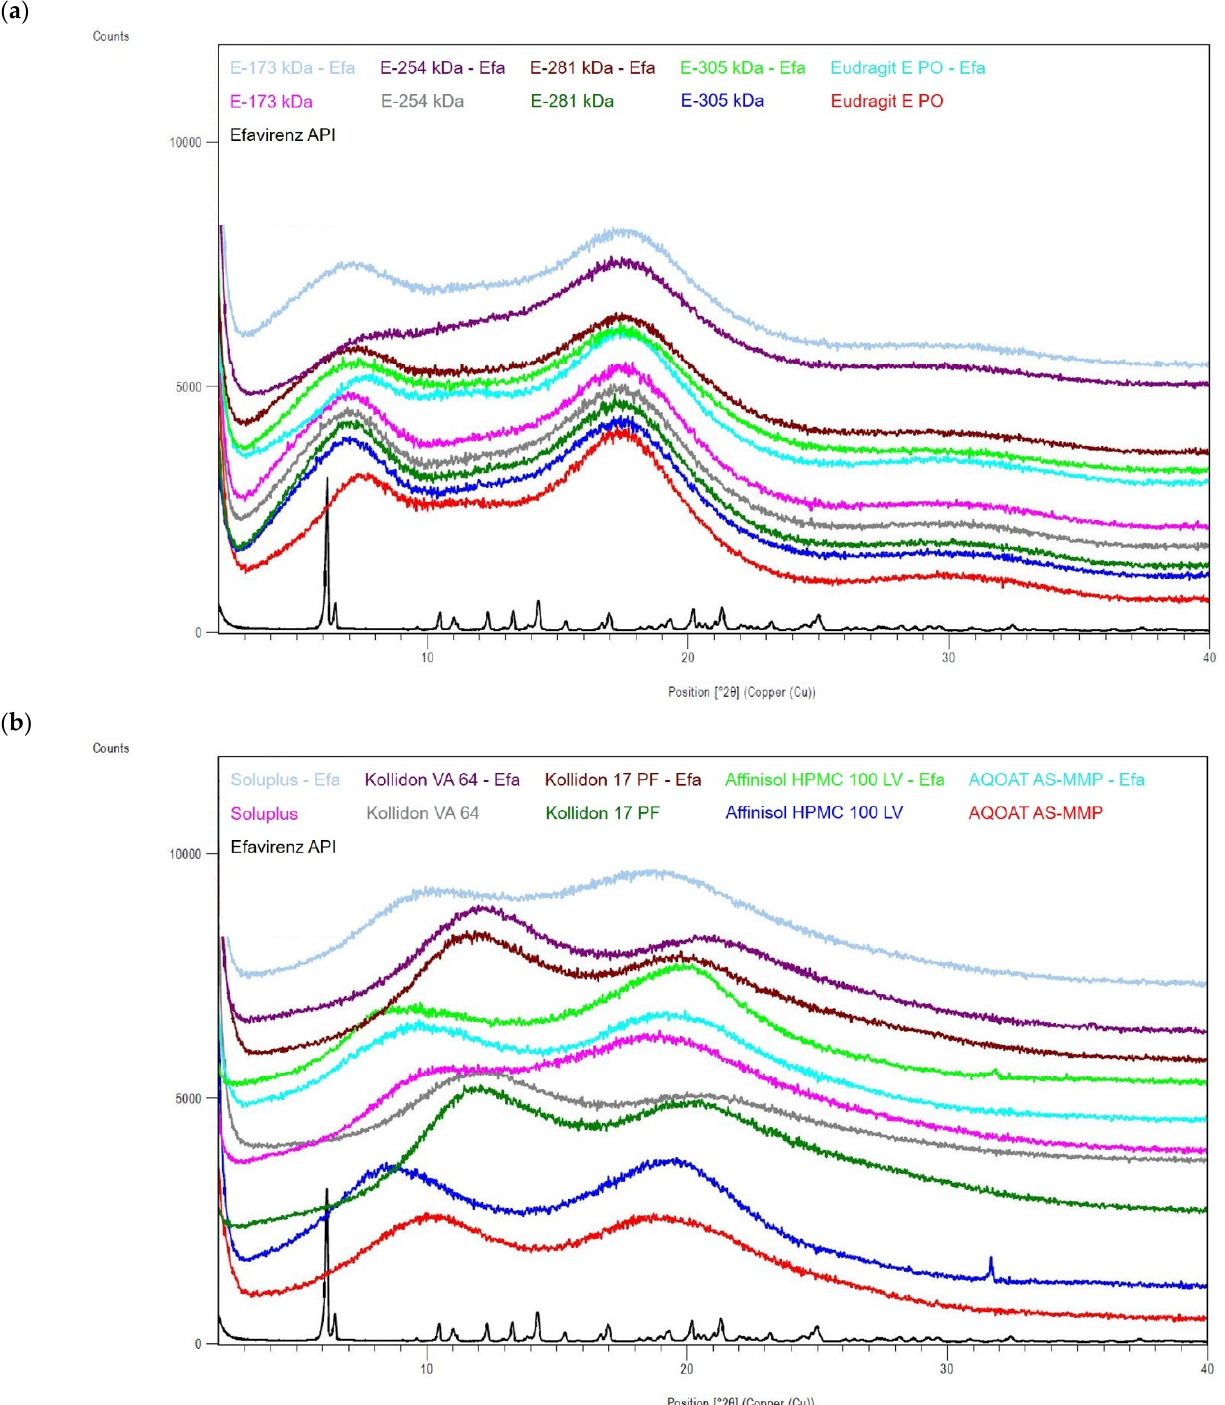
Figure 3. X-ray powder diffraction (XRPD) diffractograms of the drug substance efavirenz, ModE copolymers, EPO and the corresponding ASDs ( a ), as well as efavirenz drug substance, other marketed (co-)polymers (selection) and the corresponding ASDs ( b ).